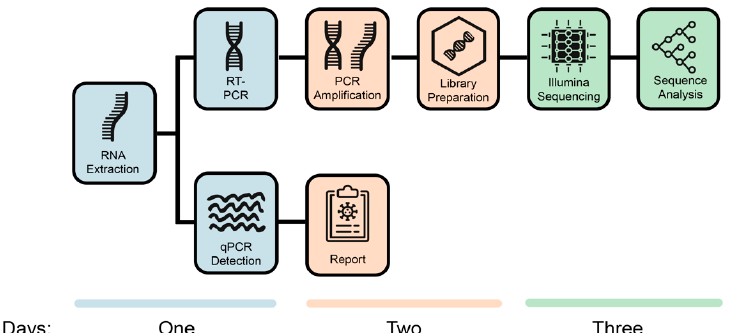
Figure 1. Processes to generate severe acute respiratory syndrome coronavirus 2 (SARS-CoV-2) genomes and qPCR diagnostics in the KwaZulu-Natal Research Innovation and Sequencing Platform (KRISP) laboratory. The figure also shows the number of days needed by two senior scientists to generate 24 whole genomes by using an Illumina Miseq Nano kit V2. It is possible to generate 94 whole genomes with one extra day of sequencing with the use of a MiSeq Reagent Kit v2 (500 cycles). In total, 102 of 108 (94.4%) samples had remaining RNA for qPCR. Of the 102 samples, 97 had positive Ct values for all three target genes, and five had at least one undetermined target gene. The